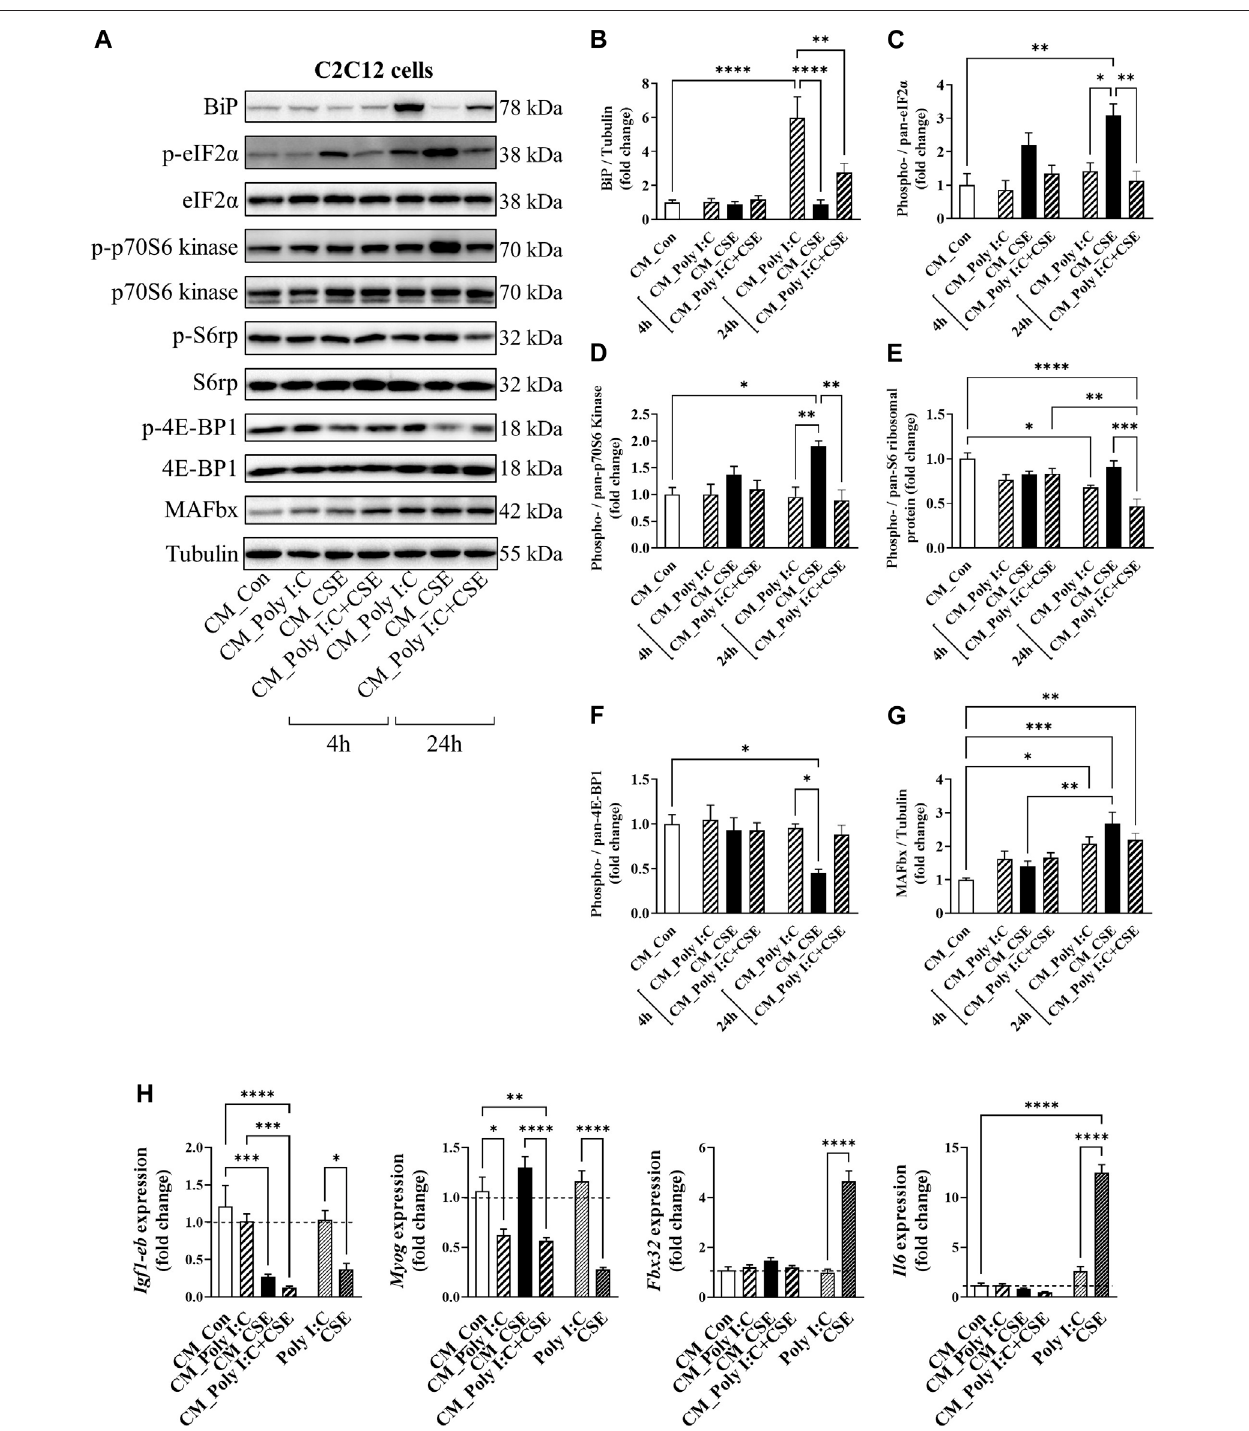
FIGURE 7 | Effect of cigarette smoke extract (CSE) and poly I:C conditioned media (CM) on proteostatic signaling of C2C12 myotubes. CM derived from BEAS2B cells exposed for 6 h to polyI:C, 25% CSE or a combination of the two was transferred onto differentiated C2C12 myotubes. (A) Western blot images and densitometryanalysisof (B) BiP, (C) phospho(ser51)-/pan-eIF2 α , (D) phospho(Thr389)-/pan-p70S6kinase, (E) phospho(Ser235/236)-/pan-S6ribosomalprotein, (F) phospho(Thr37/46)-/pan-4E-BP1,and (G) MAFbx. (H) qPCRanalysiswasperformedtoassessexpressionof Igf-1eb,Myog,Fbx32andIl6. Datashownasmean +SEM ( n = 7 – 9 per group). * p < 0.05, ** p < 0.01, *** p < 0.001, **** p < 0.0001.